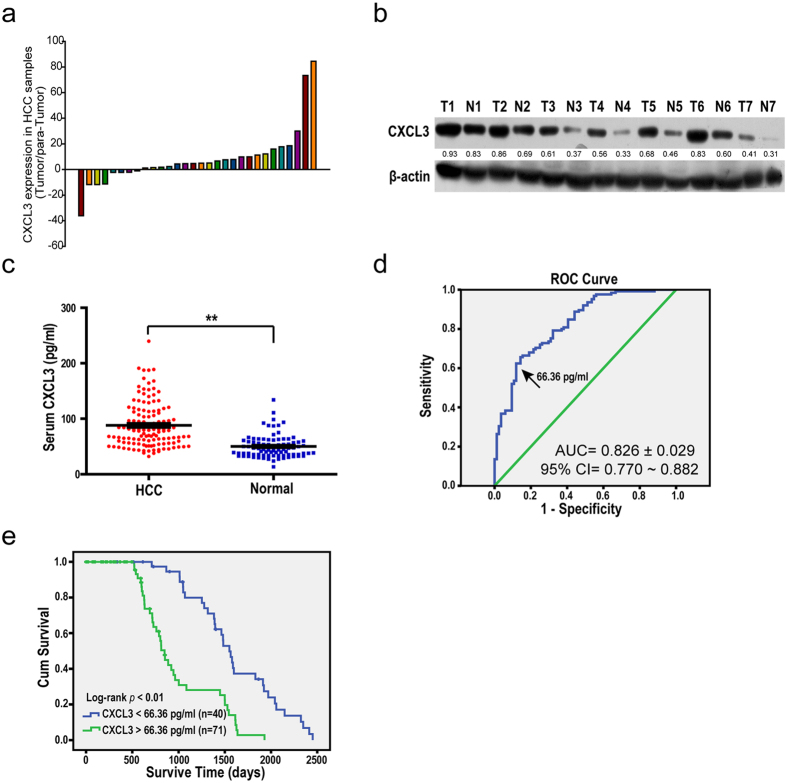
HCC patients with high CXCL3 expression level associated with unfavorable prognosis.(a) Realtime PCR analysis demonstrated that HCC tumor tissue samples expressed higher level of CXCL3 mRNA (22/30) compared with the para-tumor tissue samples. (b) Western blotting analysis of 7 pair tissue samples showed that CXCL3 HCC tumor tissue samples (T) expressed higher level of CXCL3 protein compared with the para-tumor tissue samples (N). Uncropped full-length blots were showed in the Supplementary Data. (c) ELISA results displayed that serum CXCL3 lever was higher in HCC patients (p = 0.0418)(values were represented as the mean ± SD; **p < 0.01; t-test, vs normal people control). (d) The cutoff value of 66.36 pg/ml for serum CXCL3 with a sensitivity of 62.4% and specificity of 88.1% using receiver operating characteristic analysis. (e) Results of overall survival analysis of serum CXCL3 in HCC patients are shown (Kaplan-Meier analysis).